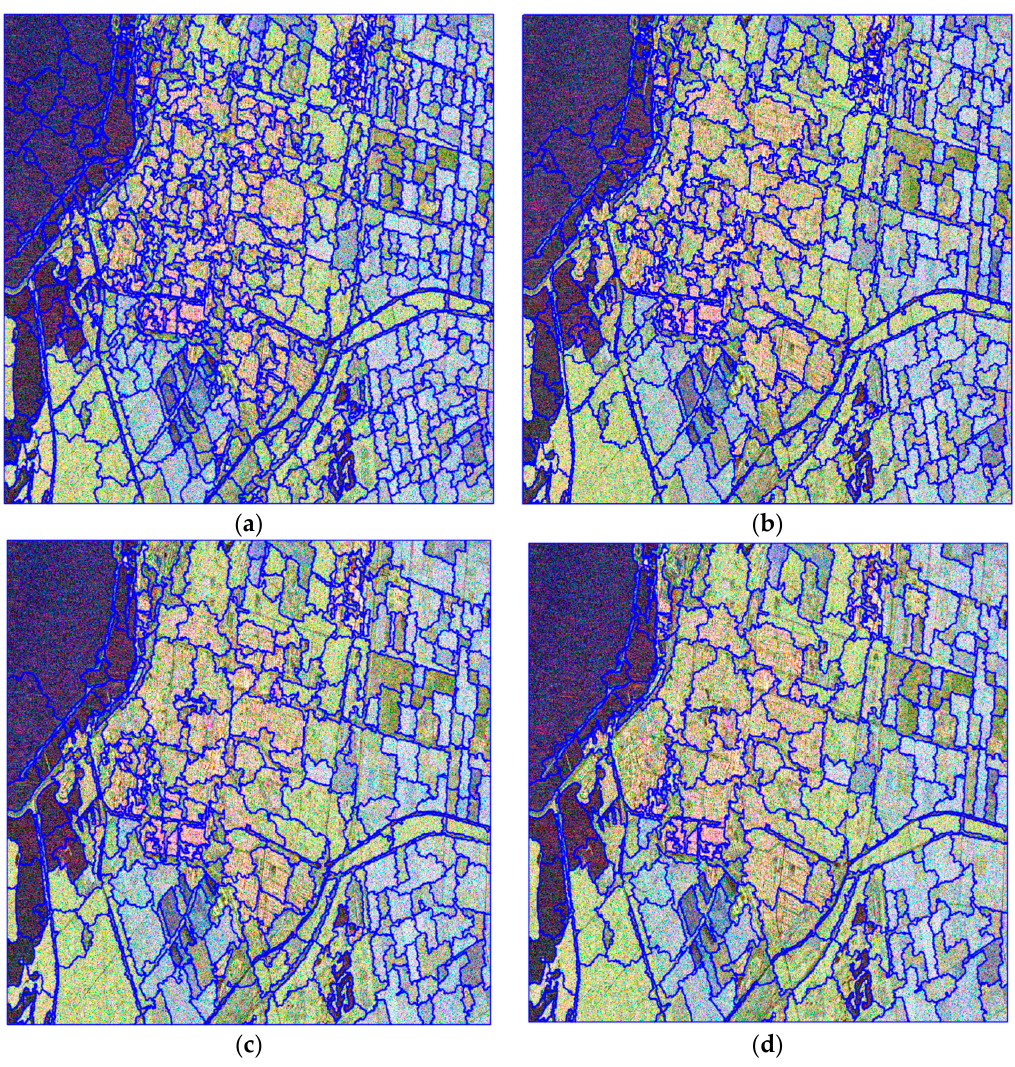
Figure 15. Segmentation results of the single-look RADARSAT-2 PolSAR image with different scales: ( a ) scale = 12; ( b ) scale = 16; ( c ) scale = 20; ( d ) scale = 25.